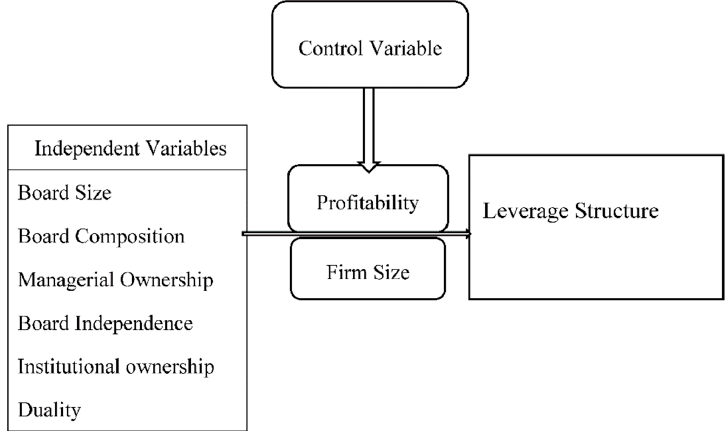
Figure 1. Relationship between dependent and independent variables. Source: Variables have been compiled by the researchers.